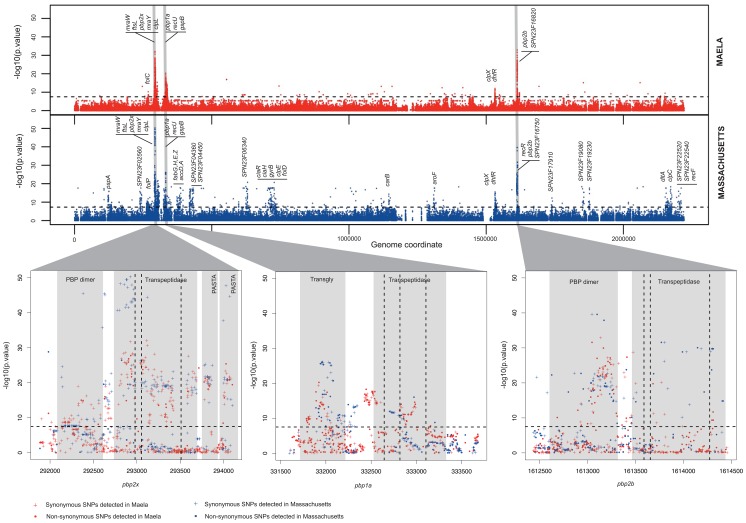
Summary of the genome-wide-association study conducted in two separate datasets.Manhattan plots summarize the association of whole-genome SNP variants with beta-lactam susceptibility in the Maela and Massachusetts data as well as particular gene regions which show strong associations. Top panel represents the statistical significance of association (y-axis) for each variant arranged in order on the genome (x-axis) in the Maela (red) and Massachusetts (blue) data. Horizontal dotted lines in both top and bottom panels indicate a significance cut-off after Bonferroni correction of p = 0.01. Genes with significant associations are annotated on top. Genes coding for penicillin binding proteins: pbp2x, pbp1a, and pbp2b, whose roles in beta-lactam resistance are well characterized, are highlighted in grey. Bottom panel expands the view of penicillin binding protein genes where most of the significant associations are detected: from left to right: pbp2x, pbp1a, and pbp2b. Protein domains identified within these genes are shaded in pale grey and labelled. The vertical dotted lines represent the active sites of the transpeptidase domain. Plus signs denote synonymous SNPs and dots denote non-synonymous SNPs.